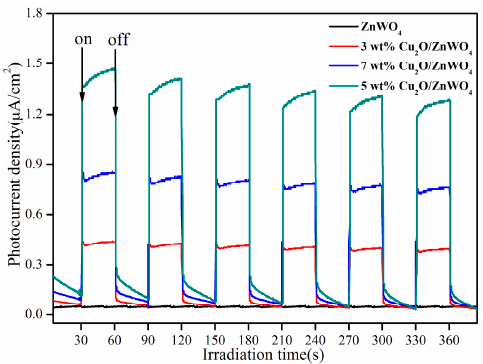
Figure 6. Photocurrent-time curves of bulk ZnWO 4 and Cu 2 O/ZnWO 4 composites under visible light (>420 nm) irradiation with 30 s light on/off cycles.